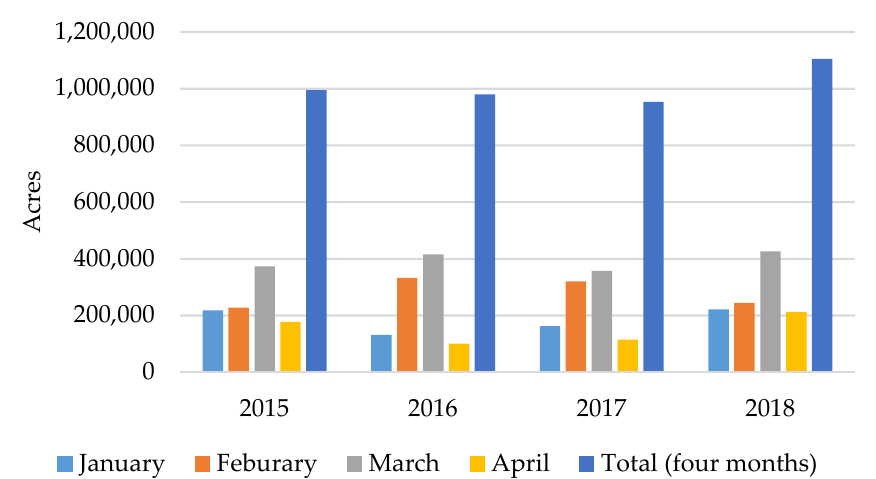
Figure 3. Total monthly burned area from 2015 to 2018 in the first four months (prescribed burning season; permit data from the Georgia Forestry Commission [GFC]).